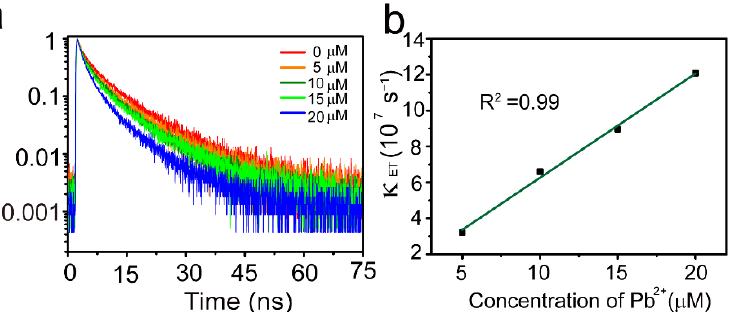
Figure 5. ( a ) Photoluminescence decay curves of MoS 2 QDs in presence of different concentrations of Pb 2+ ions (0, 5, 10, 15, 20 µ M) under pulsed excitation at 350 nm. ( b ) Dependence of electron transfer rate on concentrations of Pb 2+ ions. Table 2. Bi-exponential fitting for photoluminescence decay curves of the MoS 2 QDs. Fitting equa-